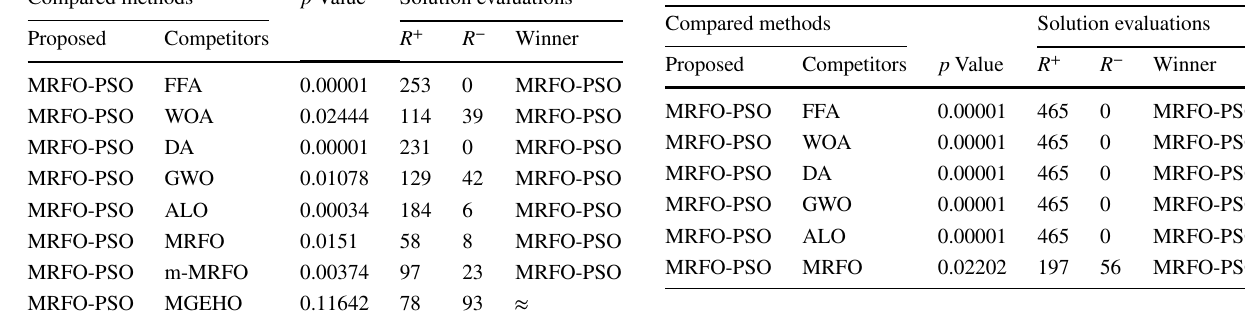
p Value Solution evaluations